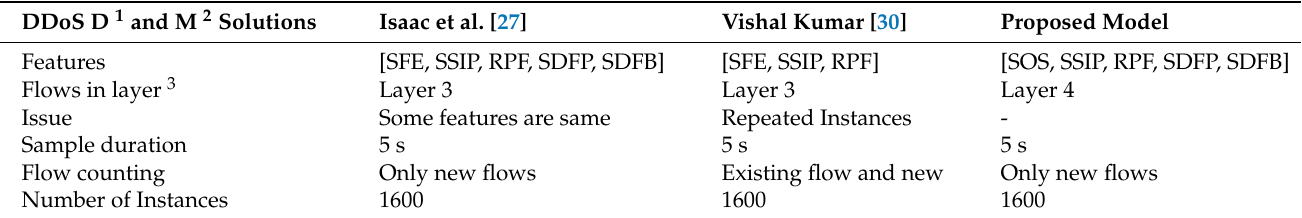
Figure 17. Accuracy comparison with existing models (Black [27], Blue [30]). Table 5. Comparison with existing